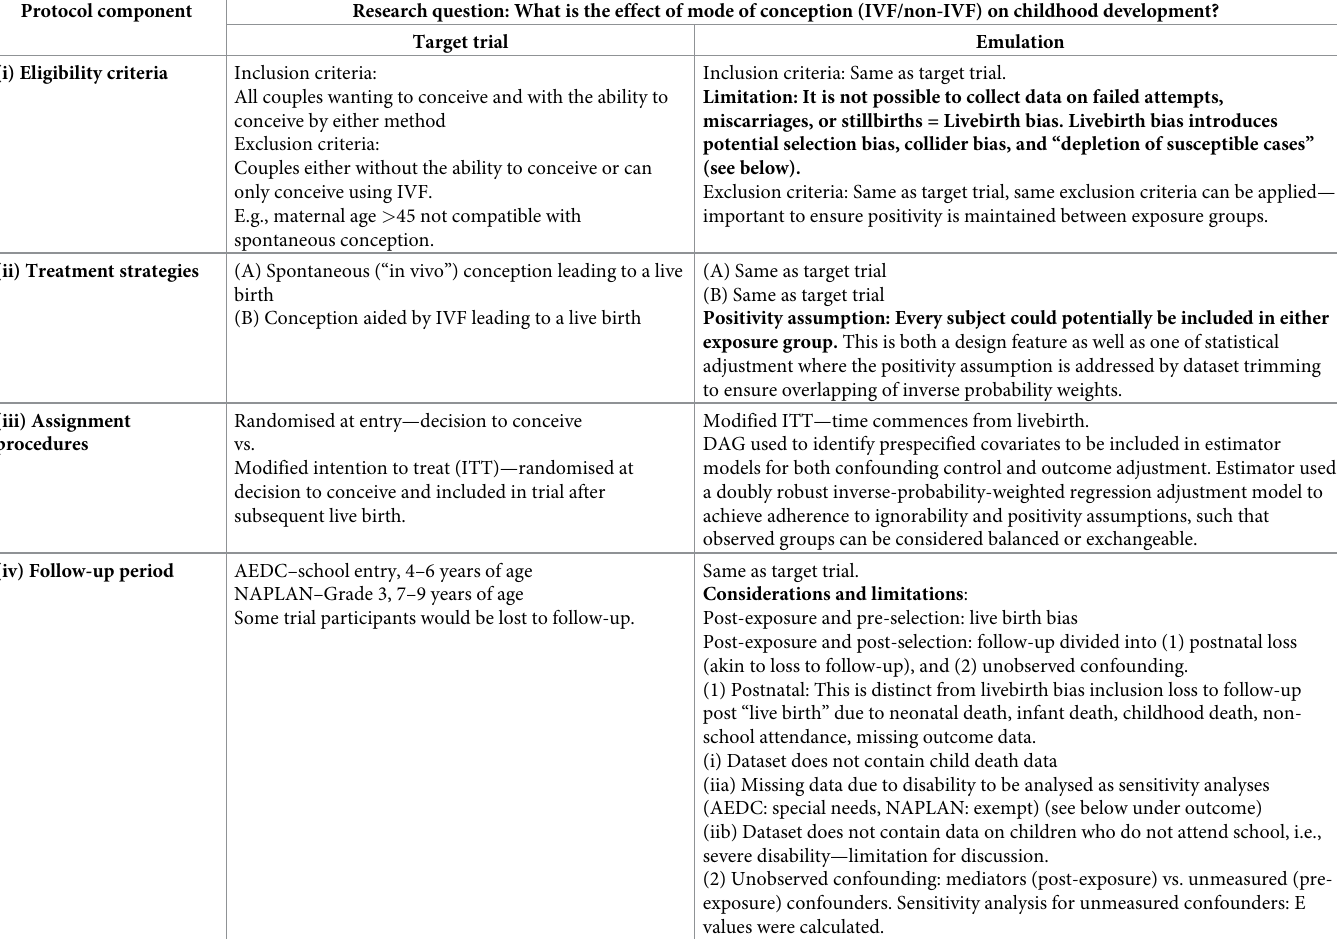
Table 1. Target trial emulation. Protocol